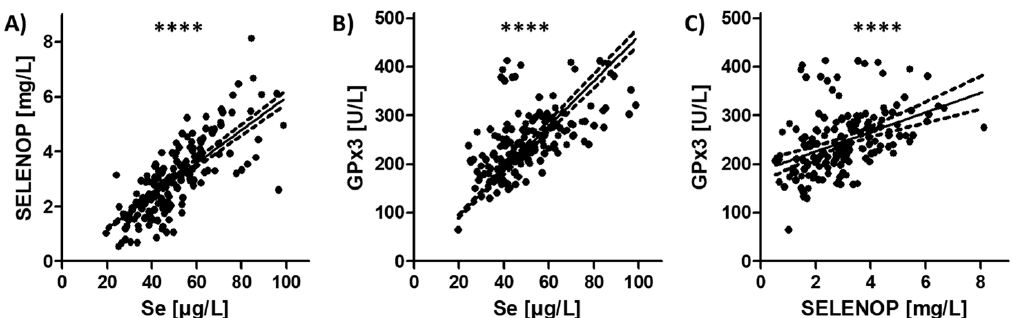
Figure 1. Analysis of Se status from samples of patients suffering from COVID-19 by three complementary serum biomarkers. Serum samples ( n = 166) were analyzed from COVID-19 patients ( n = 33) by measuring total Se concentration, serum SELENOP level, and activity of secreted